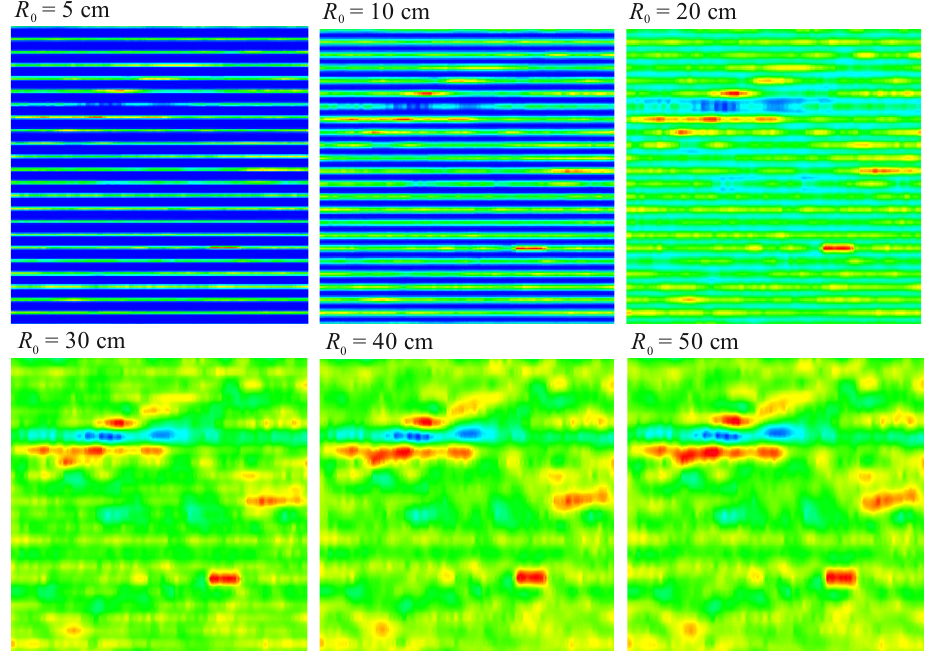
Figure 4. C-scans for different radius values.